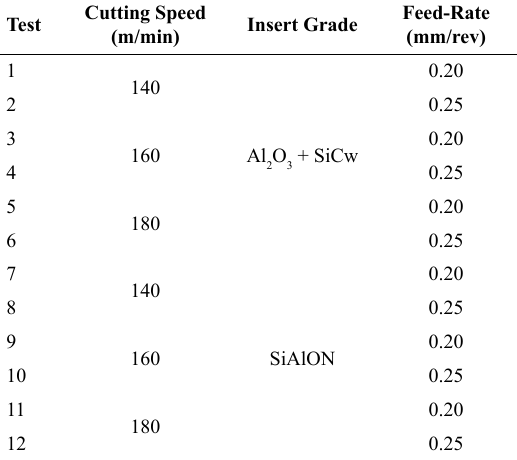
Table 2. Experimental design